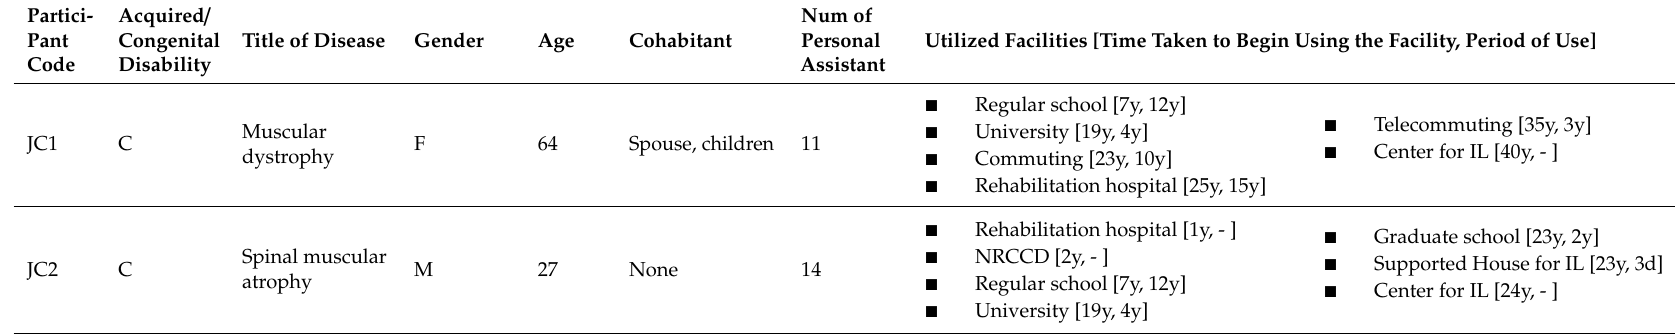
Table A3. Demographic and Disability-Related Information and Utilized Facilities of the